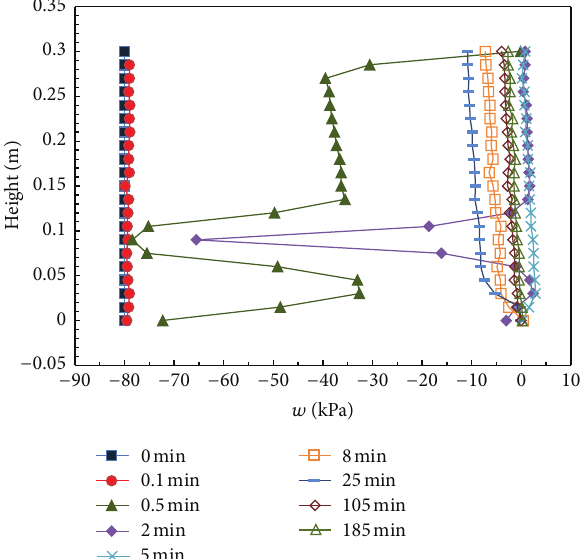
Figure 14: Variation of pore water pressure with time along Section BB 󸀠